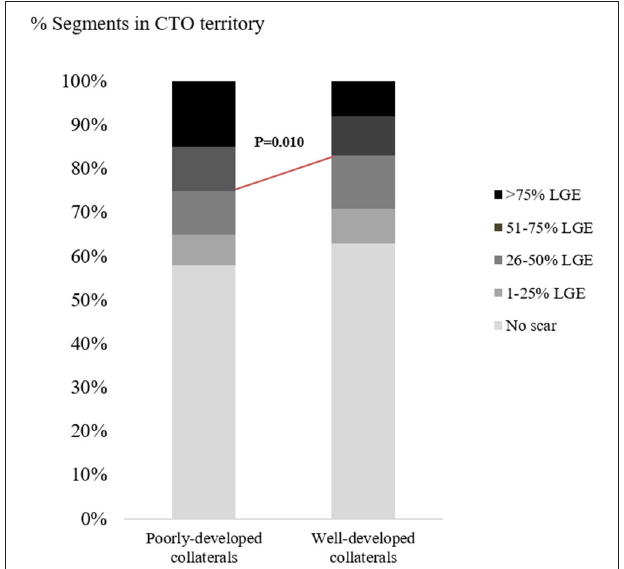
FIGURE 3 | Distribution of myocardial segments subtended by CTO arteries according to scar formation. CTO, chronic total occlusion; LGE, late gadolinium